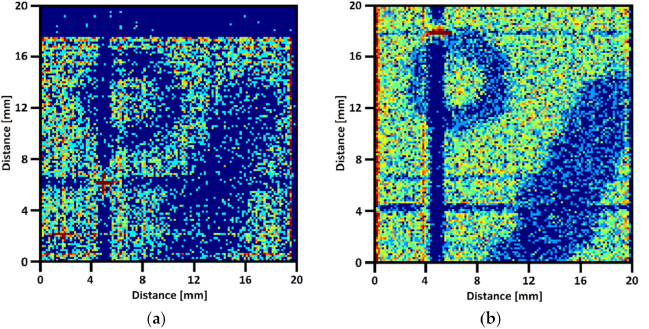
Figure 11. The radiographs of a key and an M6 nut (arrangement shown in Figure 7), measured on the ( a ) SS-GD; ( b ) MS readout